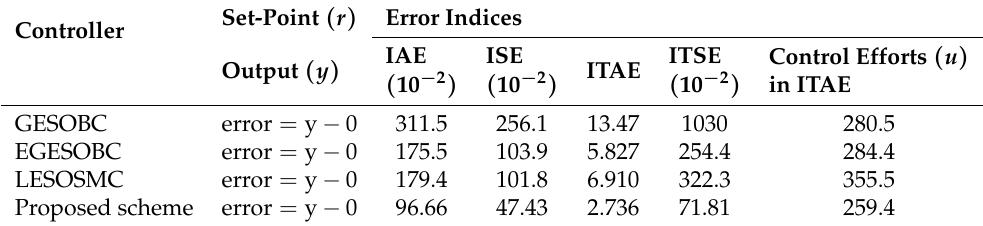
Figure 4. Error dynamics of proposed controller with reaching phase elimination for Example 1. Table 1. Comparison of performance indices for Example